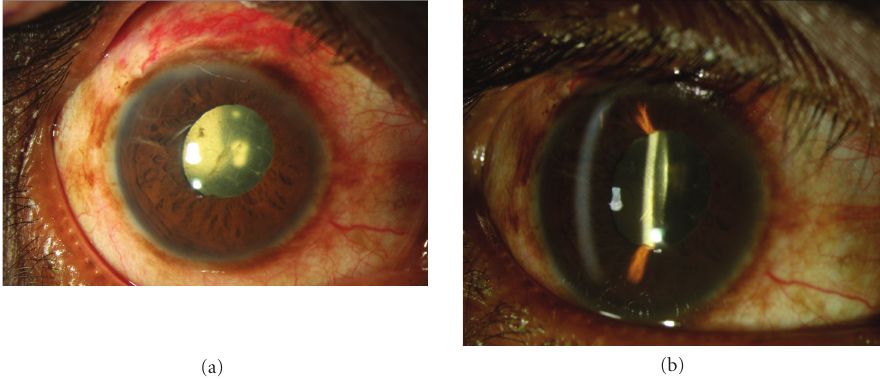
Figure 12: A 36-year-old man presented with a history of redness and pain since two years and decreased vision since one year. Examination showed a total cataract in the right eye, with 360 degrees posterior synechiae. Investigations showed HLA-B 27 was positive. After the inflammation subsided, the patient underwent cataract surgery with synechiolysis. Postoperatively, there was increased anterior chamber inflammation, which was treated with oral and topical steroids. The patient regained visual acuity of 20/25; 3 months postoperatively and is on maintenance with oral methotrexate and topical steroids. (a, b) Di ff use and slit photograph of the right eye on the first postoperative day shows a membrane on the IOL which responded to intensive topical steroids and